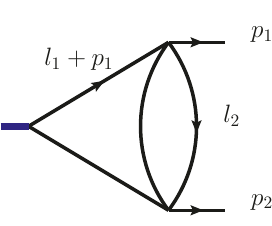
. The arrows in the diagram represent the directions 2